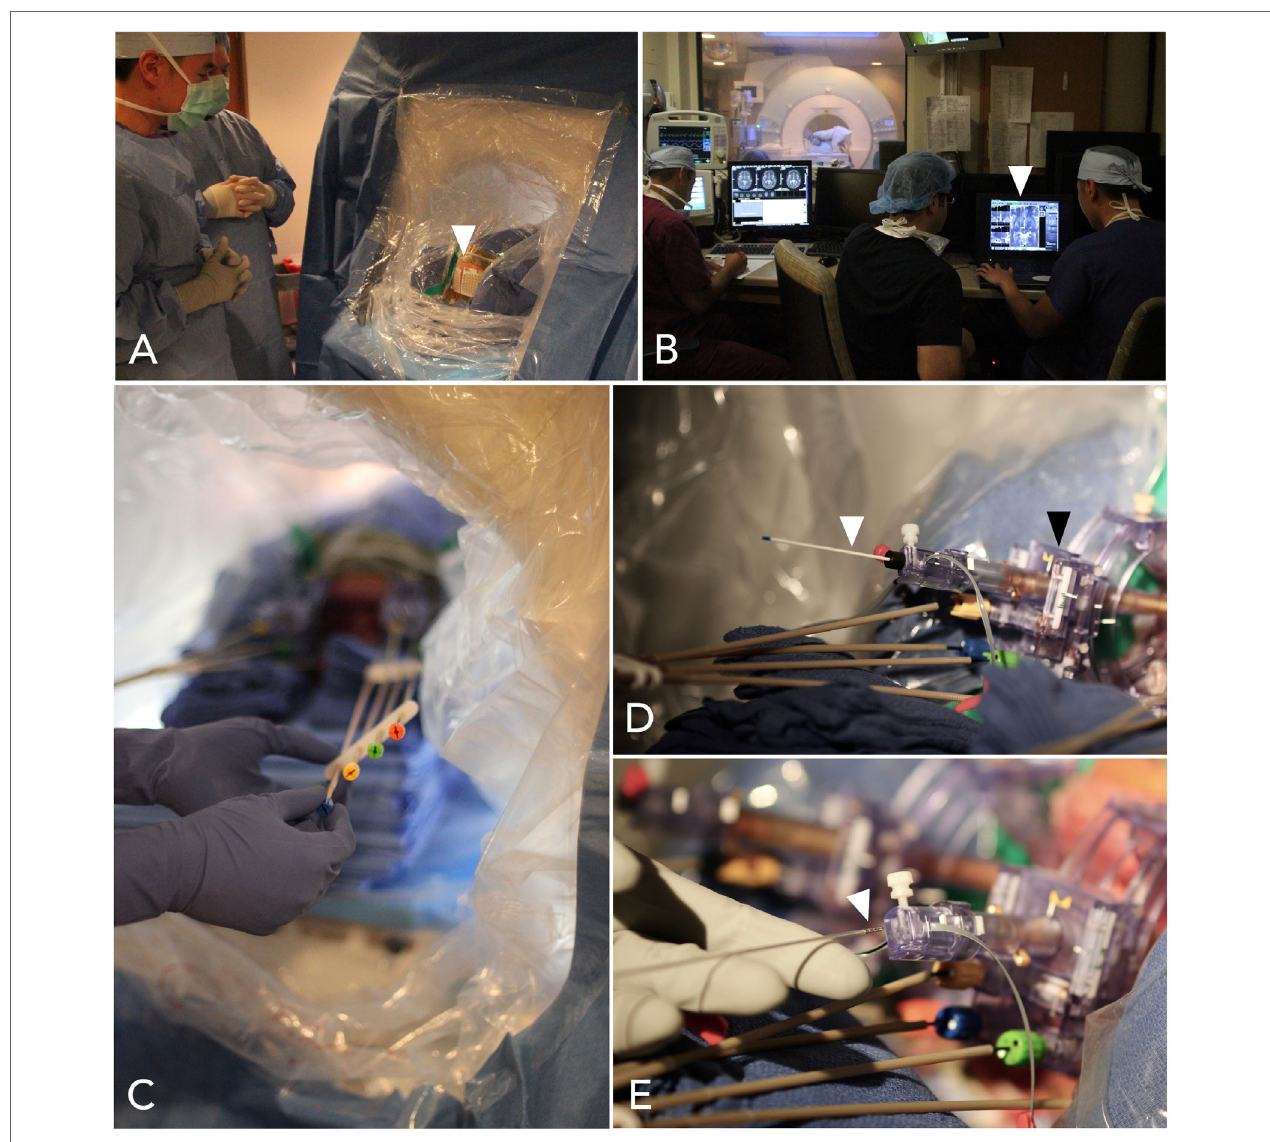
FigUre 1 | Steps in interventional-MRI-guided deep brain stimulation (DBS) lead implantation. (a) The patient is positioned supine and the head is sterilely draped within the MRI bore. MRI-visible marking grids (white arrowhead) are affixed to the scalp. (B) Volumetric scans are obtained and transferred to the ClearPoint planning station (white arrowhead), operated by the surgeon near the MRI console. (c) Instructions from the software are used to align the trajectories, by turning knobs affixed to a skull-mounted guide-frame. (D) When the guide-frame (black arrowhead) has been aligned such that the trajectory has a predicted radial error less than 0.5 mm, a ceramic stylet (white arrowhead) is placed to target depth, through a thin plastic sheath, and a scan is obtained to confirm accurate location. (e) A DBS lead (white arrowhead) is then placed through the sheath to target